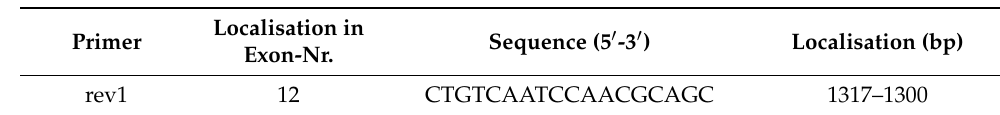
Table 3. ING3 reverse